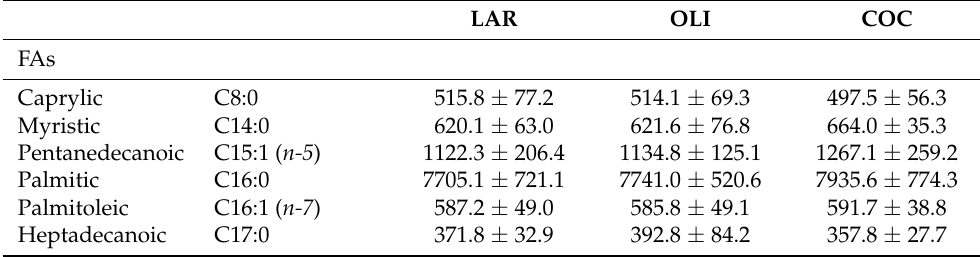
Table 3. Fatty acid (FA) compositions in the frontal cortexes of pigs fed LAR, OLI, and COC diets. Samples were analyzed by gas chromatography and values expressed as absolute FA composition. Values are means ± SDs. COC, coconut oil diet; FA, fatty acid; LAR, lard diet; LCFA,